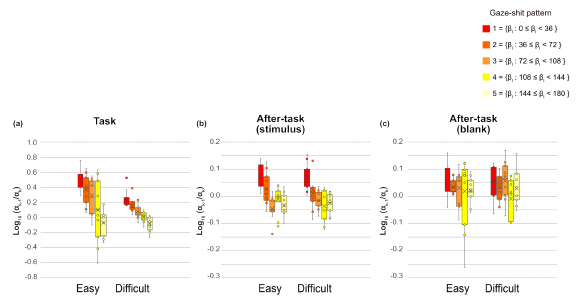
Figure-07 . ( !"# of each gaze-shift pattern and task phase for ( ! each task difficulty level. Circles are outliers, Xs are mean, lines in side boxes are median line, lines in upper boxes indicate max- imum, and those in lower boxes indicate minimum. Boxes range from 25 to